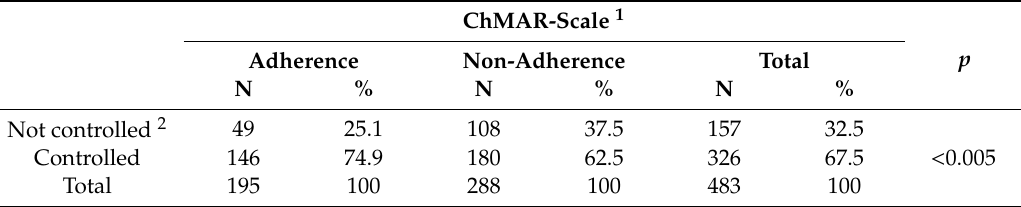
Table 2. Blood pressure (BP) control rate vs. adherence based on the